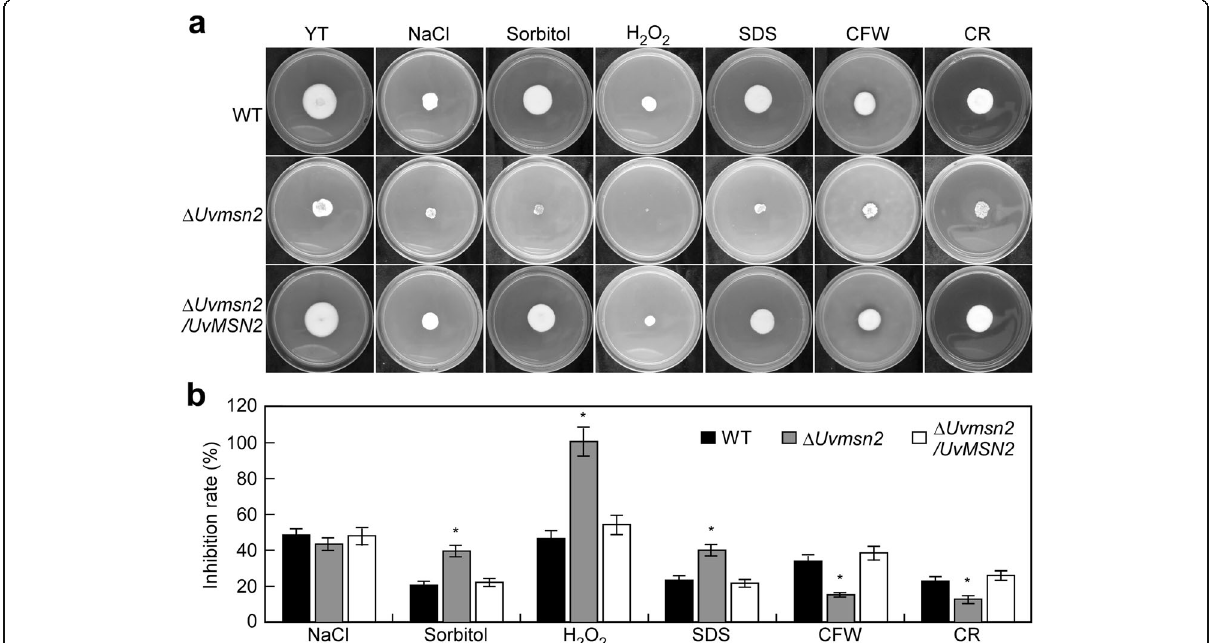
Fig. 4 UvMsn2 plays a crucial role in regulating stress responses in Ustilaginoidea virens . a The wild-type HWD-2, Δ Uvmsn2 and Δ Uvmsn2 / UvMSN2 strains were incubated on YT agar plates supplemented with different stress agents at 25 °C for 14 days. b Statistical analysis of the growth inhibition rate of the indicated strains exposed to different stresses. The mean values ± SD were calculated from three independent experiments, and asterisks indicate a statistically significant difference from the wild-type strain ( P < 0.01)